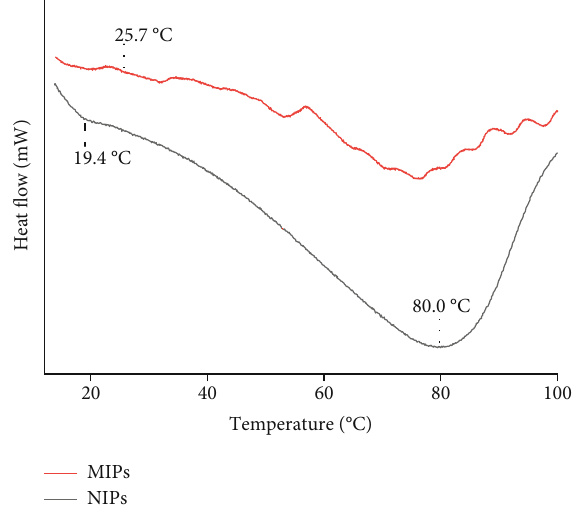
Figure 7: The DSC curve of MIPs and